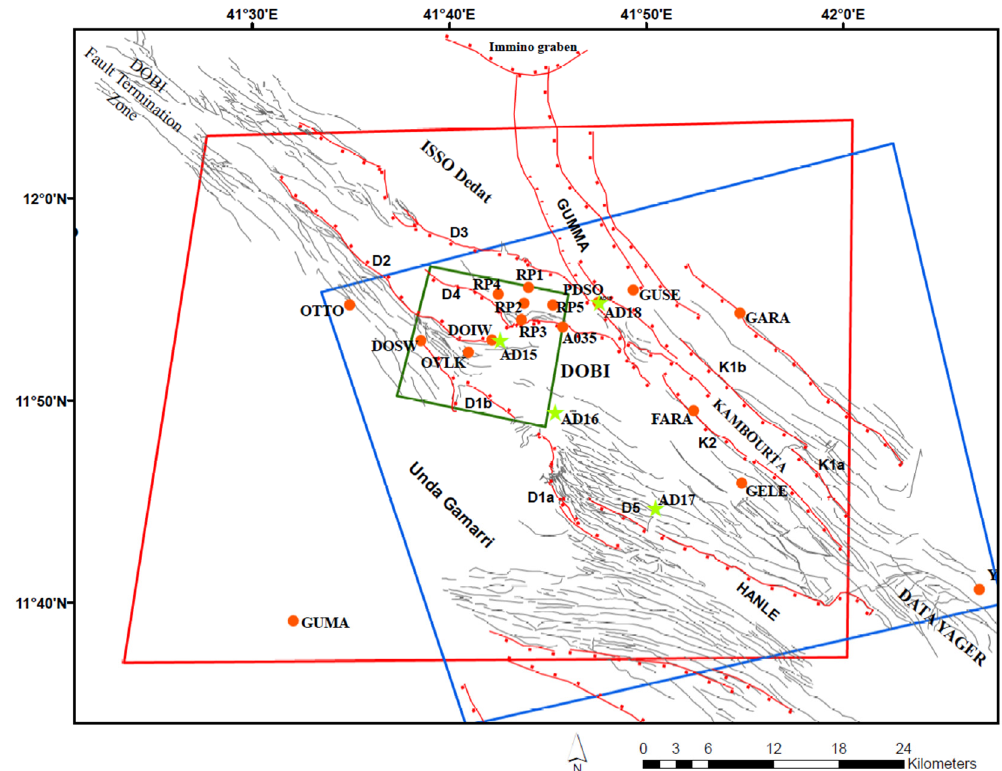
Figure 2. Structural map of the Dobi graben produced from the interpretation of 0.46 m spatial resolution panchromatic images collected by Worldview-2 satellite and 1-arc second (30 m) Shuttle Radar Topography Mission’s (SRTM) digital elevation model (DEM). Light blue polygon represents the portion of the ascending tract 257 orbit considered and the orange polygon represent the descending 006 tract. The ticked red line represents the first-order normal faults that bound the graben, while the gray line represents the second-order normal fault. The orange dot points represent the available GPS sites in the region and the light green stars represent the broadband seismic data of the Reciver Function. The nomenclature of the faults is strictly adopted after that of [12].